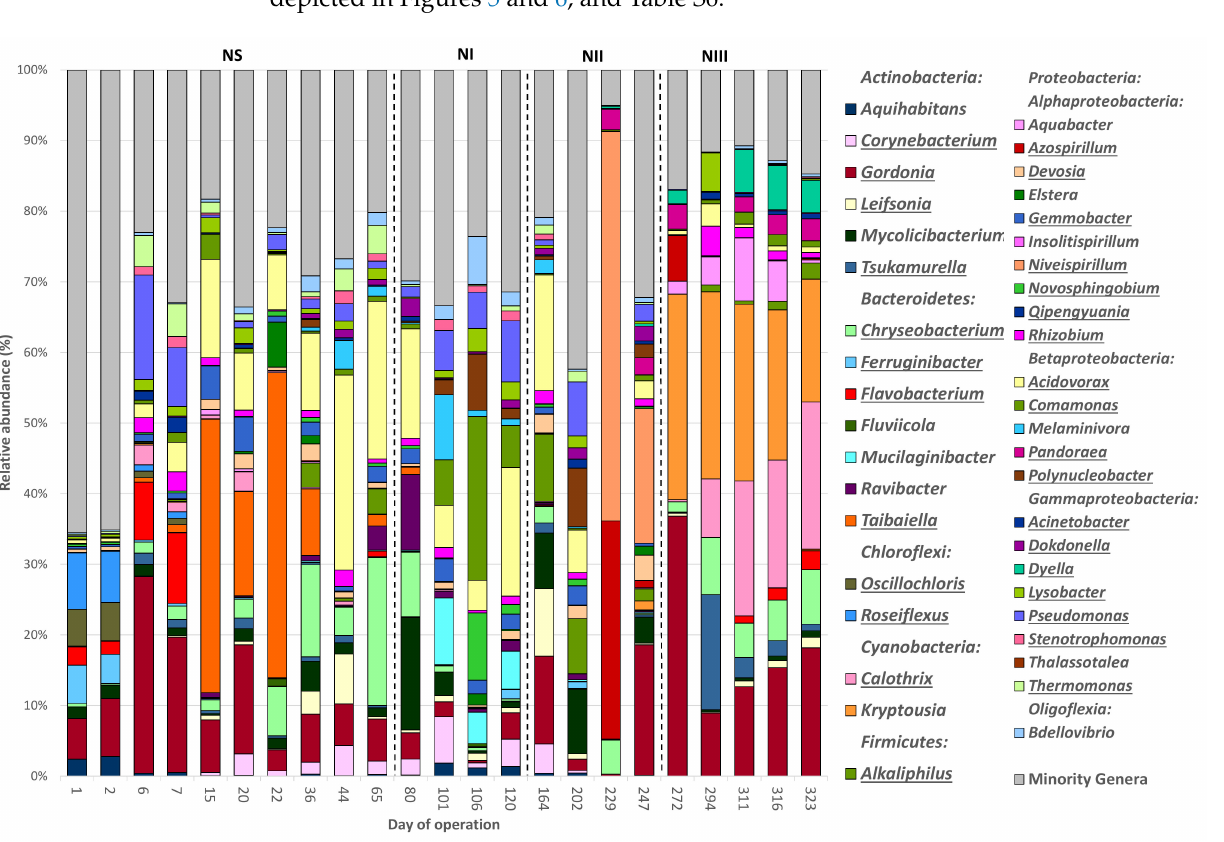
Figure 5. Average relative abundance of the main bacterial genera (RA > 0.5%) found in biomass sam- ples retrieved from an enrichment SBR operated under non-saline conditions (SBR-N, 0.5 g NaCl/L). Genera potentially able to accumulate PHAs or described abundant in other PHA-accumulating SBRs are